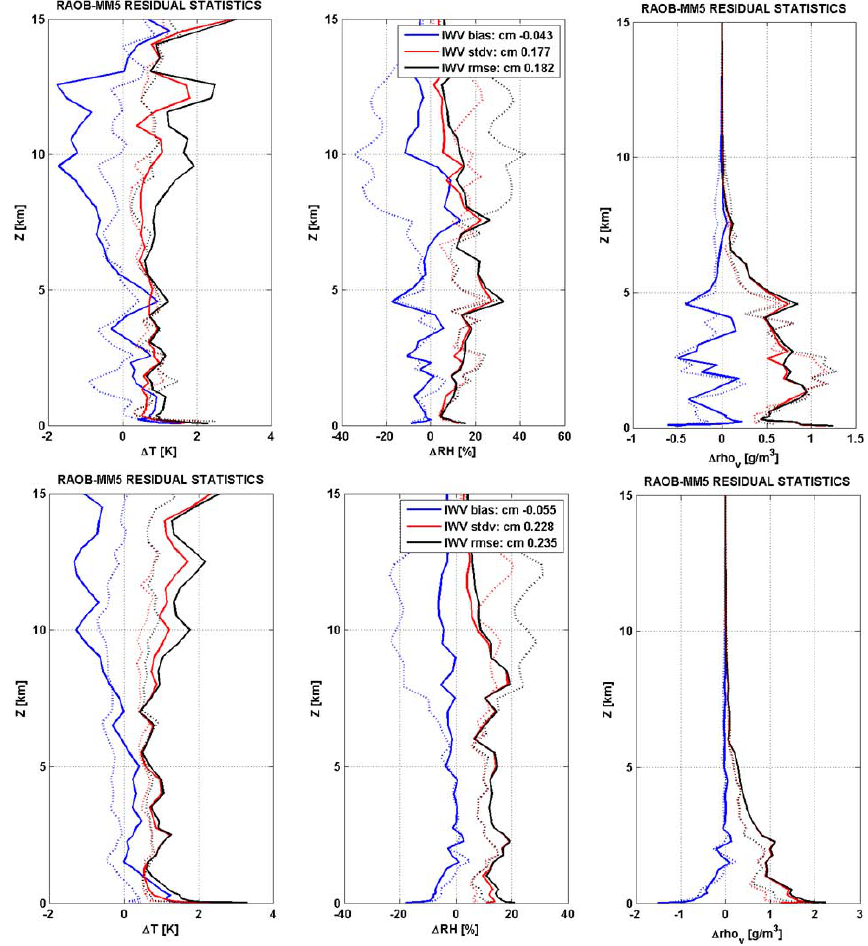
Fig. 2. Statistics of the difference ( 1) of MM5 (solid) and ECMWF (dotted) temperature (left), relative humidity (center), and water vapor density (right) with respect to RAOB lunched at DIESAP (top) and PDM (bottom). Blue lines indicate profiles of mean difference (bias), red lines indicate standard deviation, and black lines indicate root-mean-squared